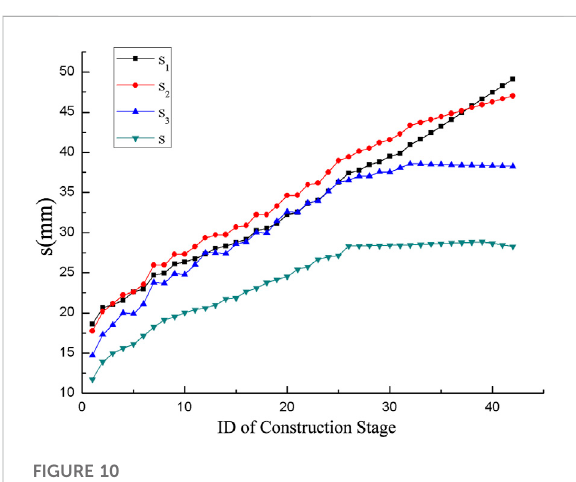
FIGURE 10 Settlement deformation at each construction stage.